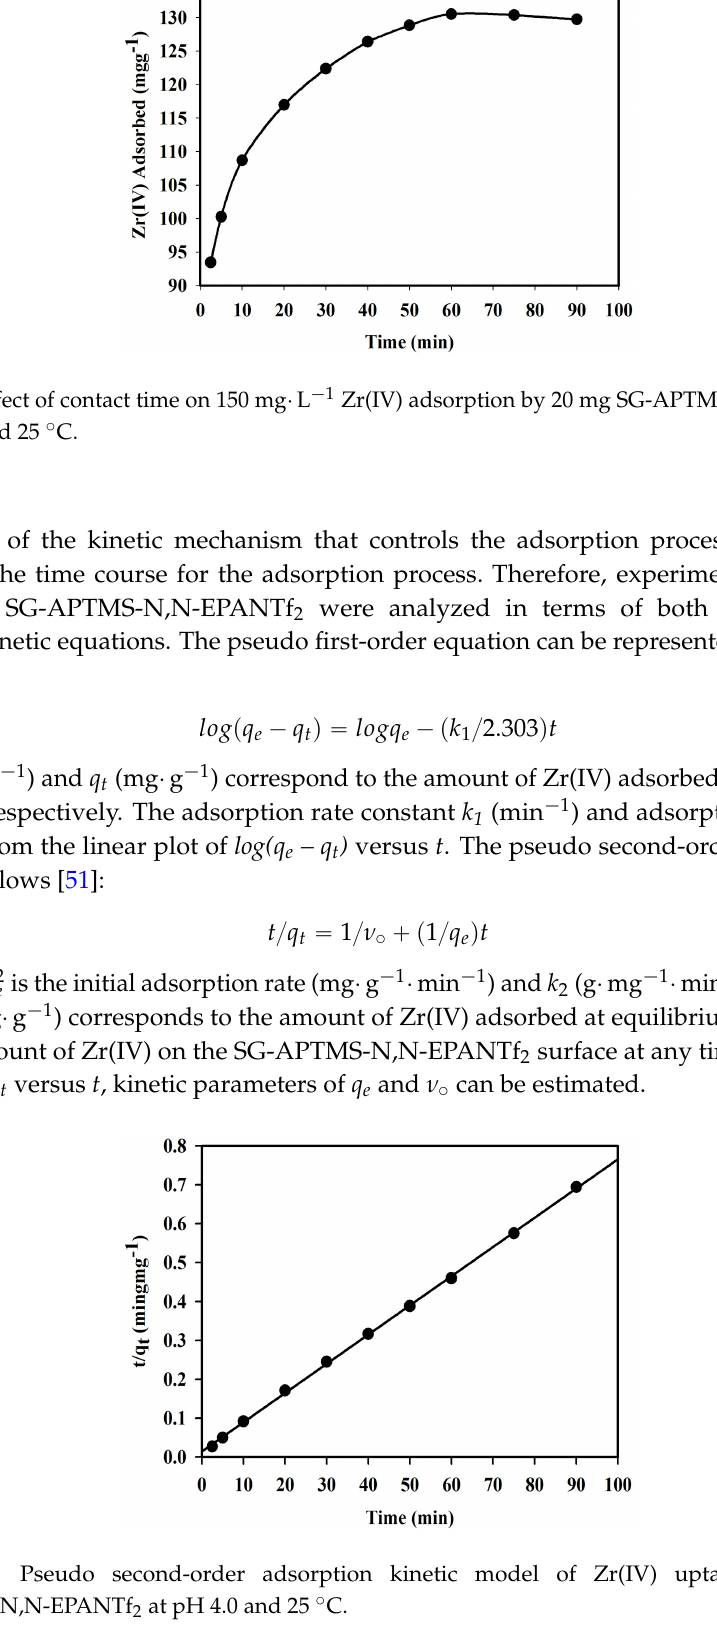
Figure 6. Effect of contact time on 150 mg·L − 1 Zr(IV) adsorption by 20 mg SG-APTMS-N,N-EPANTf 2 at pH 4.0 and 25 °C.